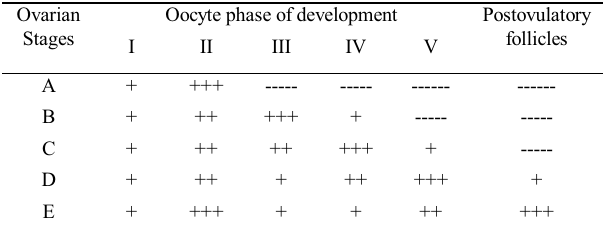
Table 1. Merluccius hubbsi : classification of ovarian matura- tion stage based on oocyte phase of development (+ current; ++ frequent; +++ predominant).